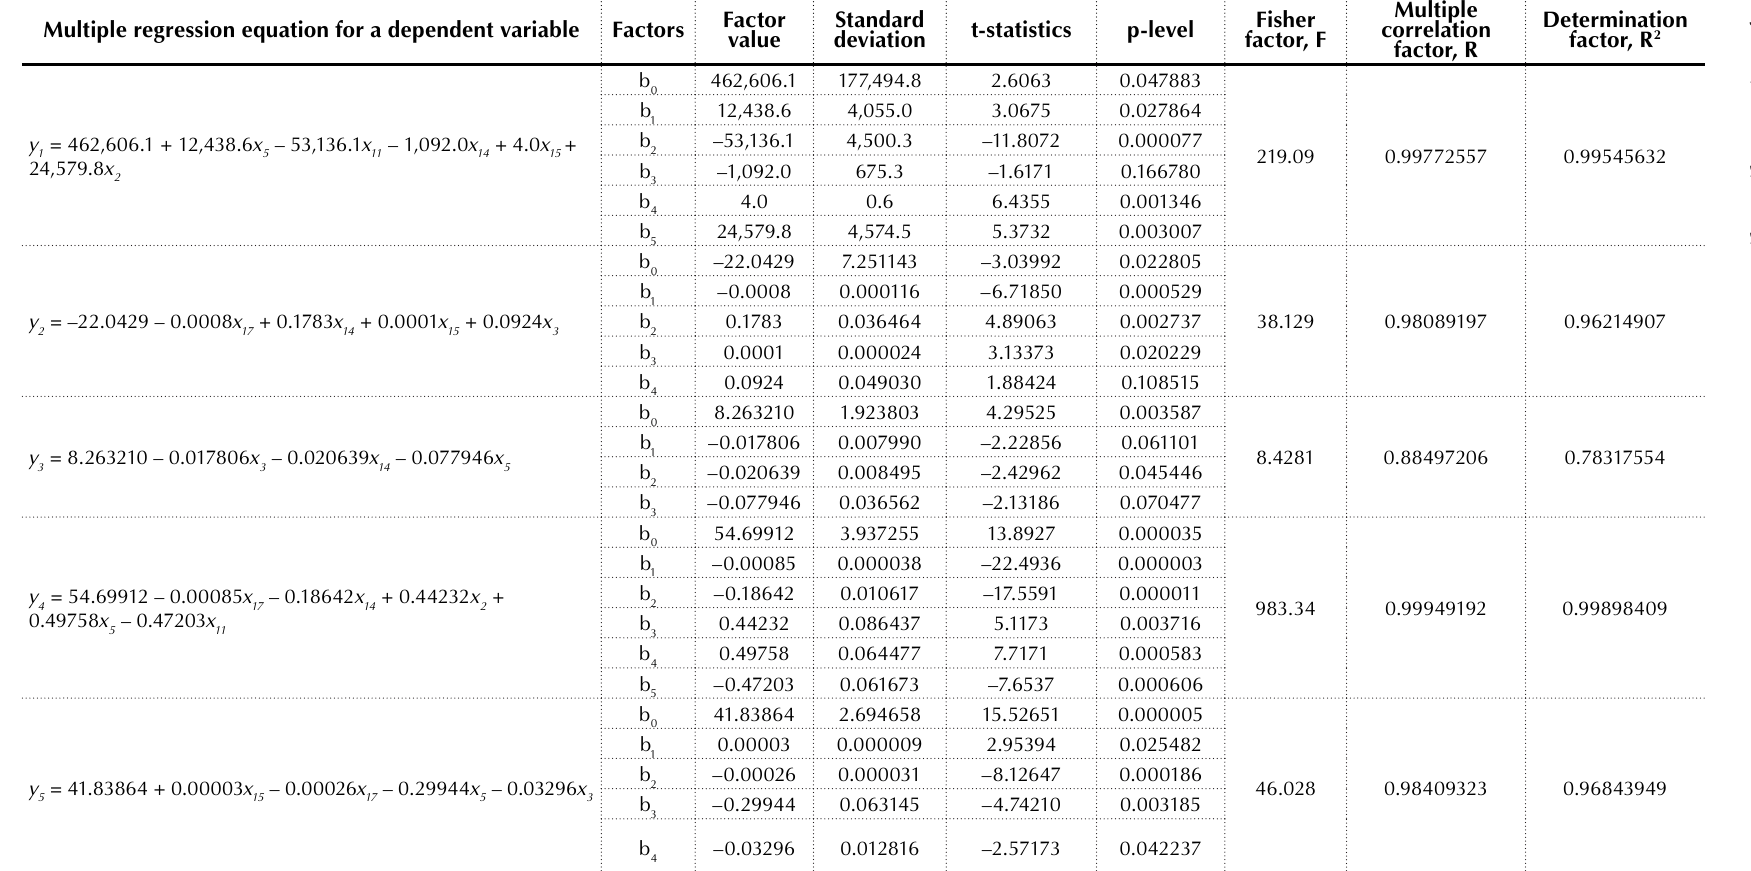
Table 5A. The statistics of the model of researching the change of financial and economic security indicators under the influence of foreign banking